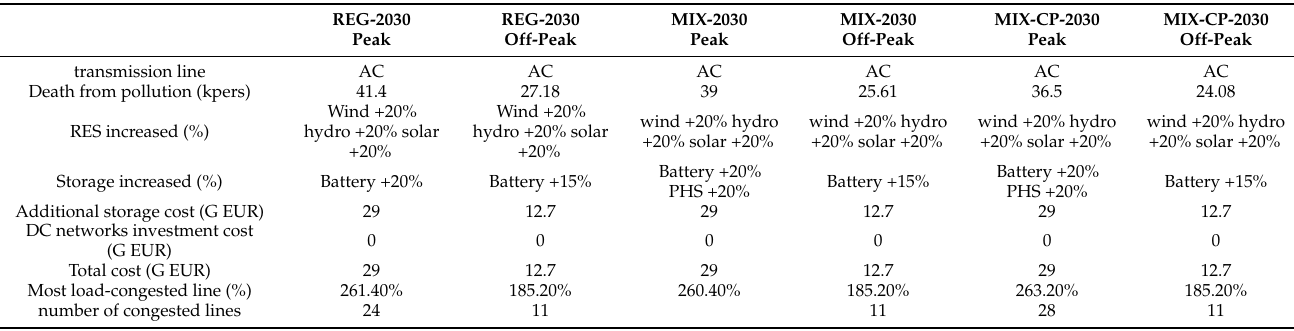
Table 2. Comparison of HVAC grid.